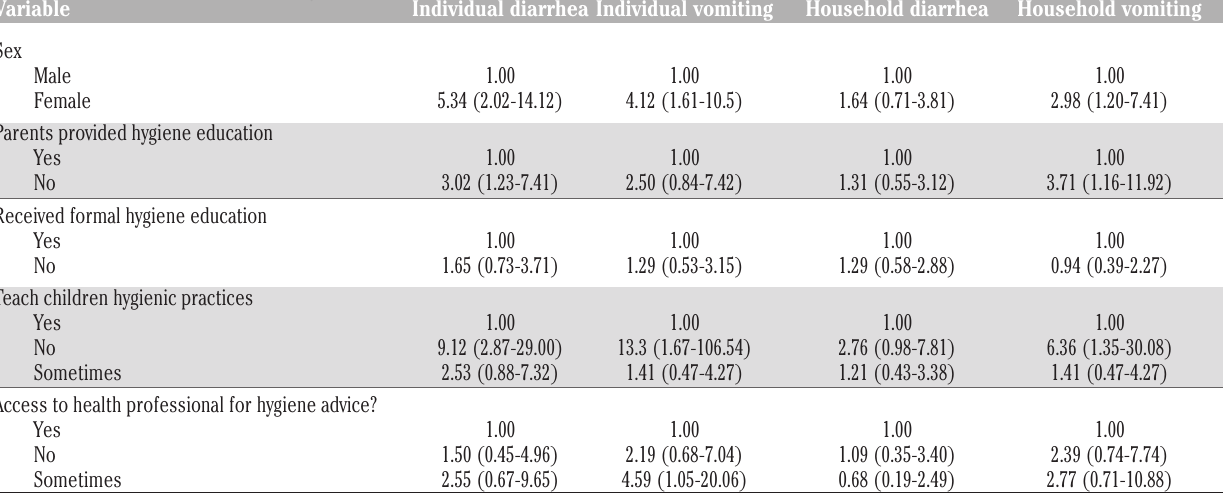
Table 3. Odds ratios and 95% confidence intervals for selected variables.